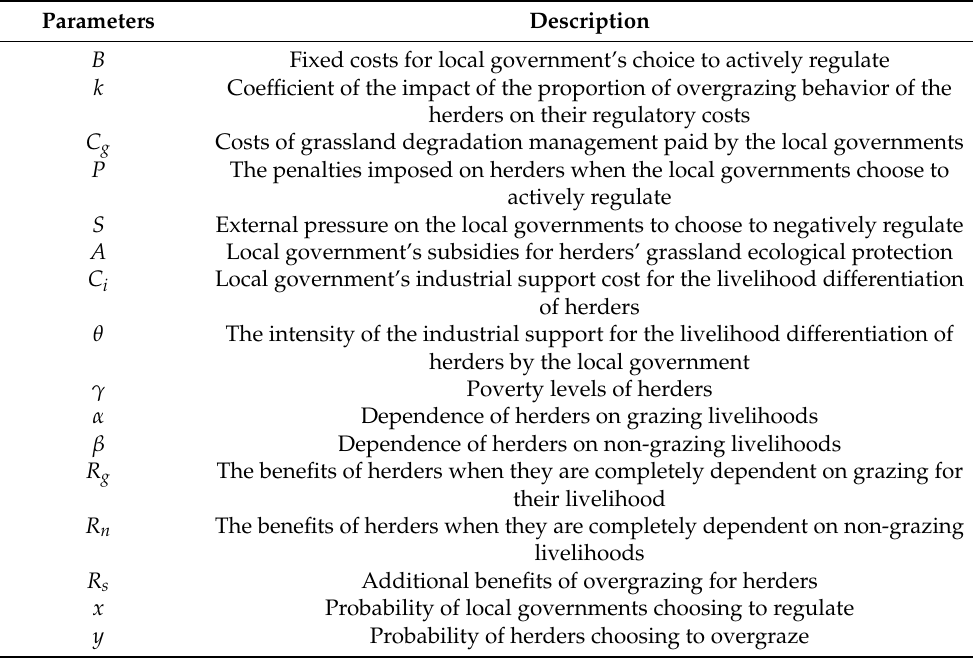
Table 1. Parameters of the evolutionary game model for the local governments and herders.